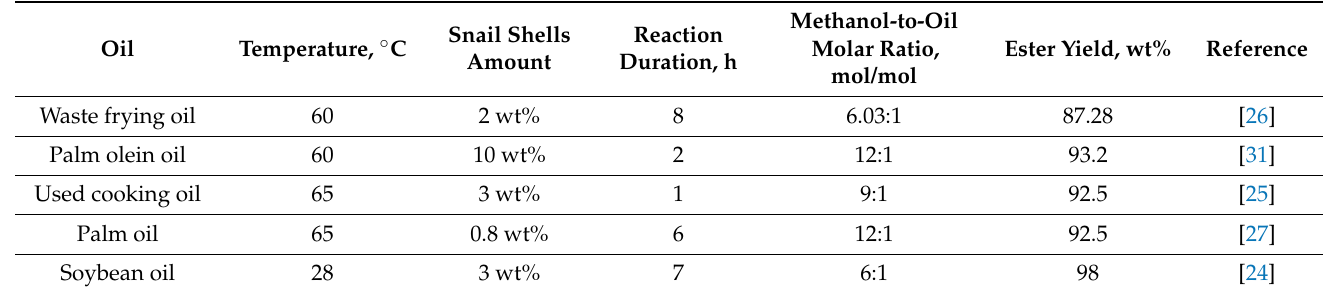
Table 5. Comparison of optimal conditions for fatty acid methyl ester production using snail shells as a heterogeneous